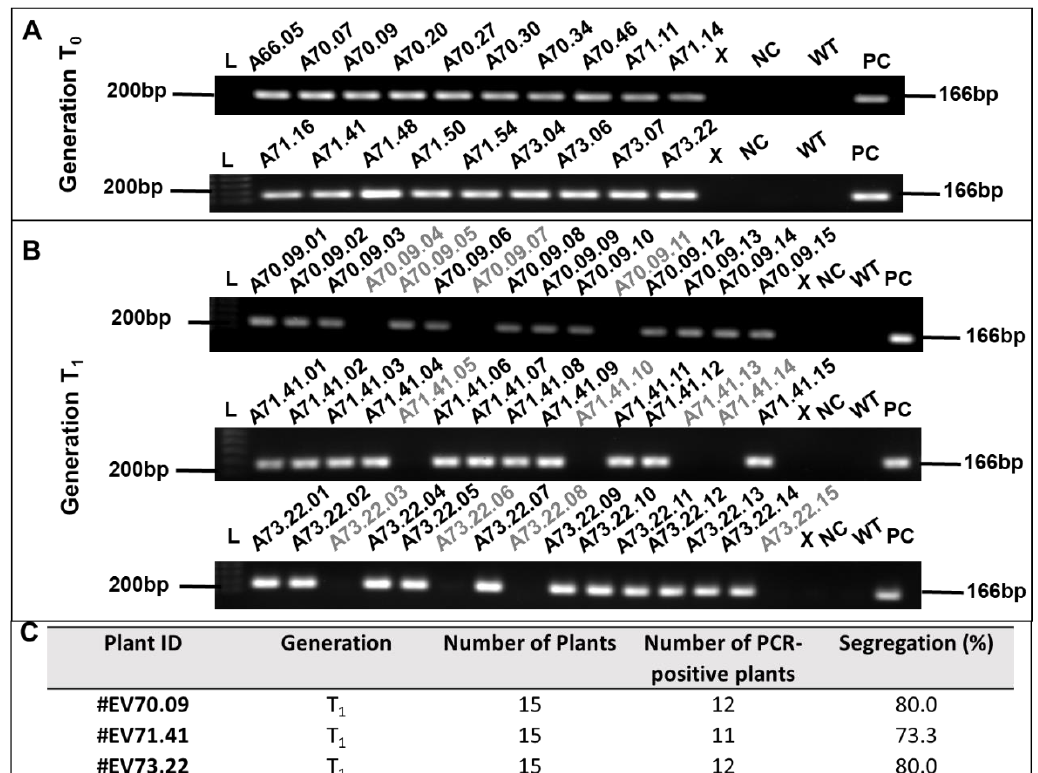
Figure 3. Transgene detection in GM T 0 and T 1 -recovered cotton events. Putative transgenic plants were accessed by dsRNA-encoding fragment (dsRNA-EF) amplification in a representative sample of putative GM cotton plants by PCR. Amplicon = 407 bp. ( A ) T 0 progeny selected in Imazapyr-supplemented medium and confirmed by ahas -targeting PCR. ( B ) T 1 progeny selected and confirmed by PCR of dsRNA-EF. ( C ) Heritability among T 1 progenies. Black letters: positive plants; Gray letters: negative plants; PC: positive control (vector with transformation cassette); WT: wild-type plants; L: 1.0 kb ladder; NC: negative control (ultrapure water). The X represents an empty well.